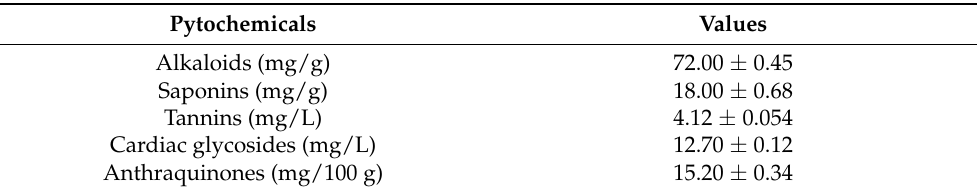
Table 1. Phytochemical Constituents of